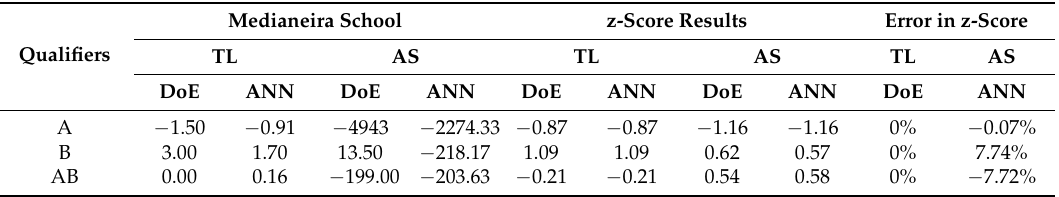
Table 14. Comparison of the results of the effects of significance applying ANN and Design of Experiments (DoE).